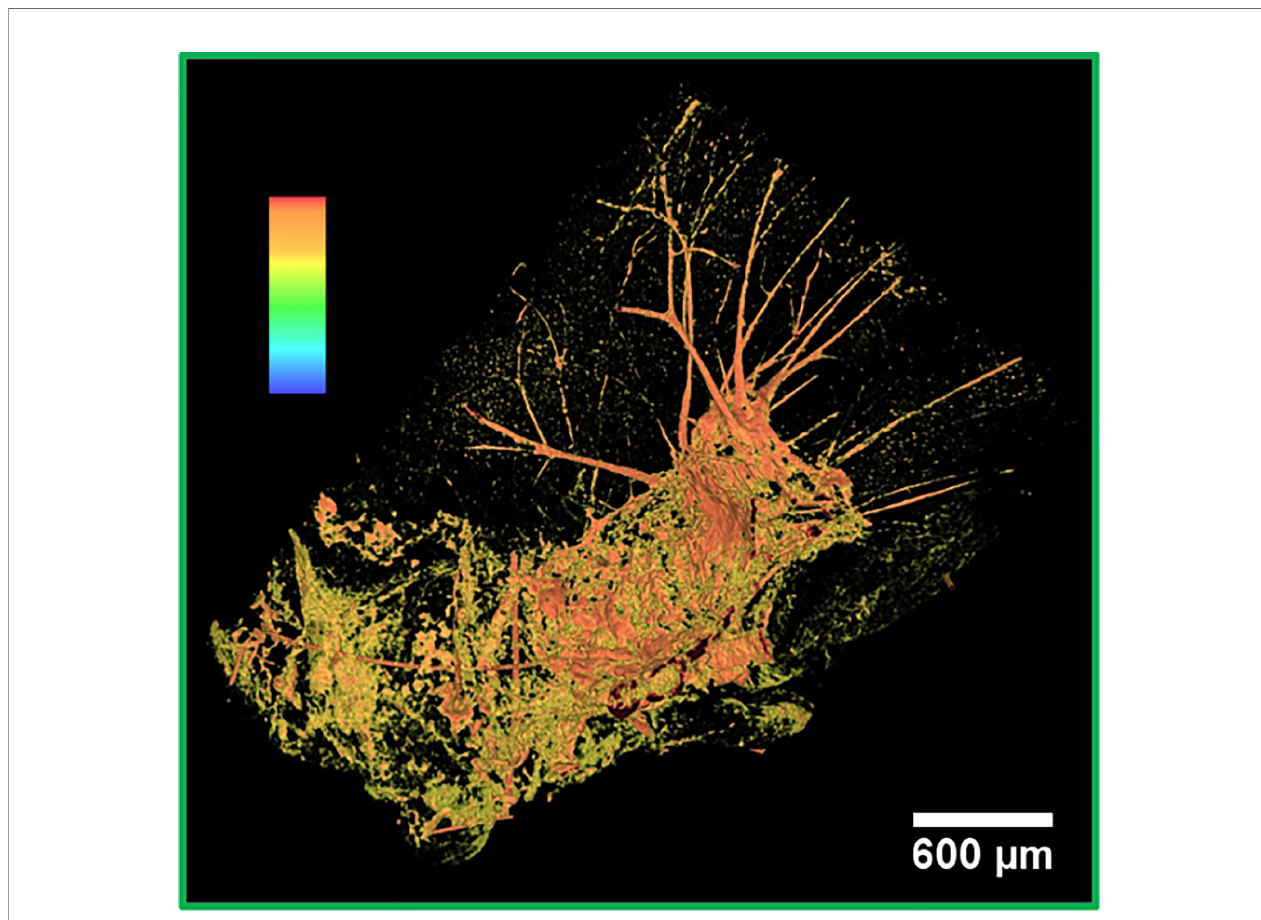
FIGURE 3 | False color 3D image of a metastasis. 3D segmented visualization in false colors of the area under the green box in Figure 2A . The highest intensity pixels, displayed in orange, correspond to the densest objects of the image, that is,